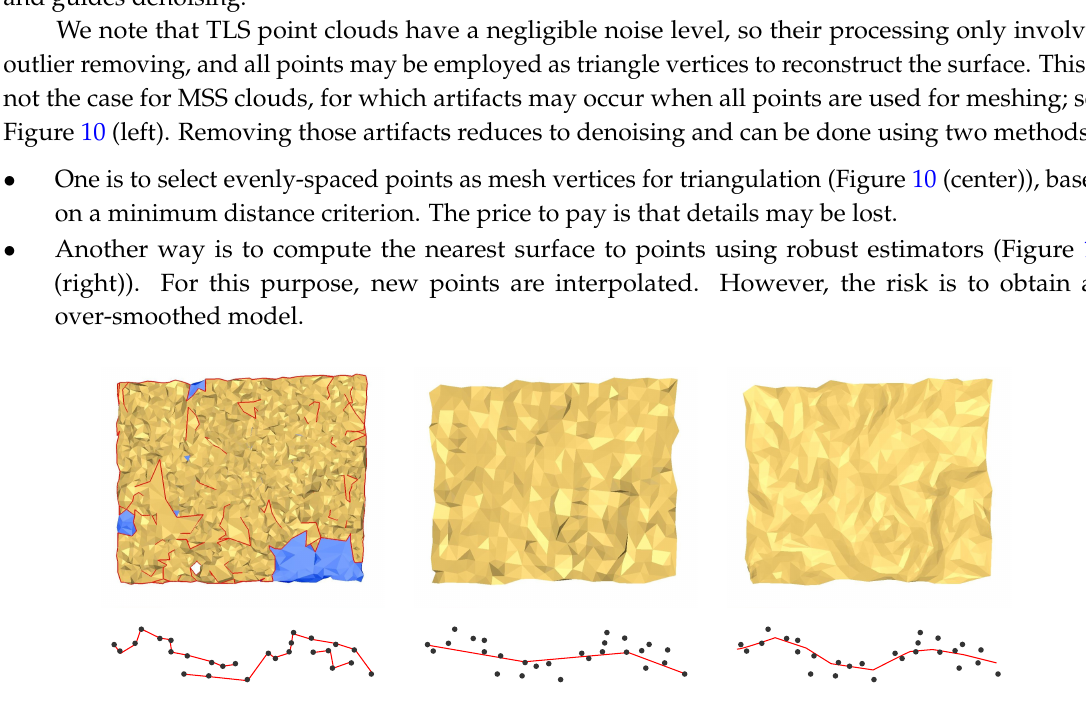
Figure 10. Methods for meshing point clouds: Using all points ( Left ); Using selected points ( Center ); Meshing using interpolated points ( Right